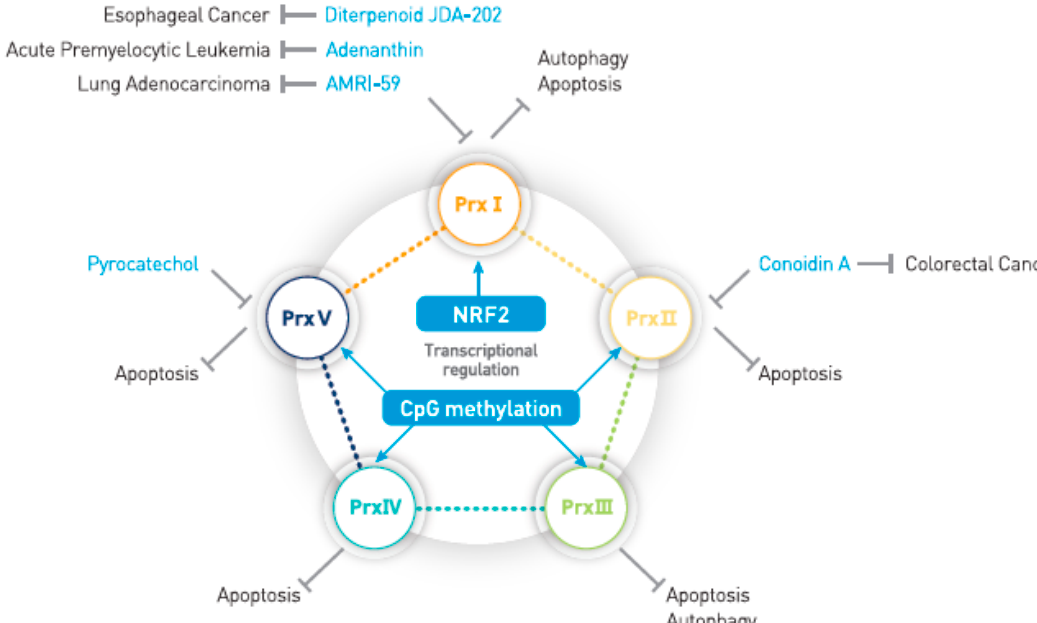
Figure 1. Regulation of the expression and activity of 2-Cys peroxiredoxins (Prxs). Prx I expression is mainly regulated by nuclear factor (erythroid-derived 2)-like 2 (Nrf2), whereas Prx II through V are regulated by promoter methylation. Note that hyper-methylation on the Prx I promoter has been reported in oligodendroglial tumors. To date, four compounds (conoidin A, adenanthin, AMRI59, and JDA-202) have been validated for inhibiting Prx I and/or Prx II in vitro and in vivo. As 2-Cys Prxs suppress the apoptosis of cancer cells, chemical inhibitors against 2-Cys Prxs are most likely to induce apoptosis in cancer cells. CpG: cytosine-guanine site.